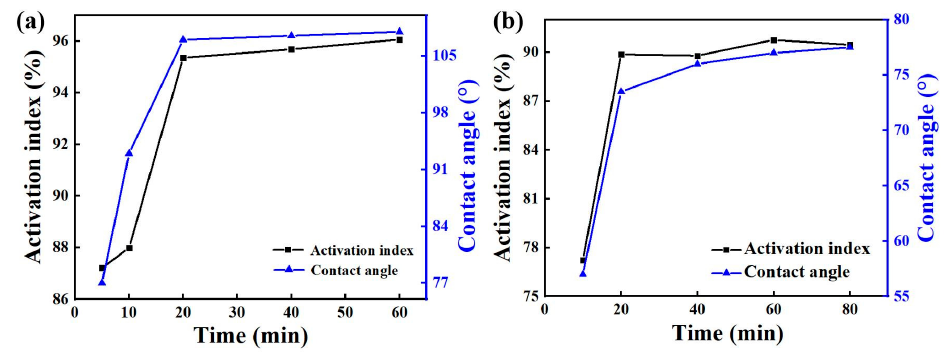
Figure 2. Effect of modification time of Octadecylamine ( a ) and Dodecyl tertiary amine ( b ) on modification. ( b ) on